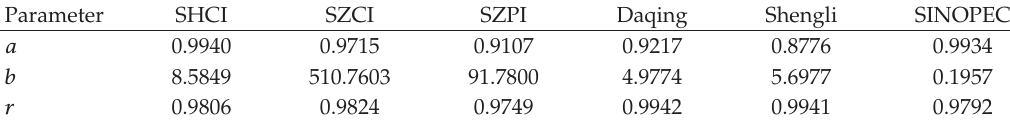
Table 1: Linear regression